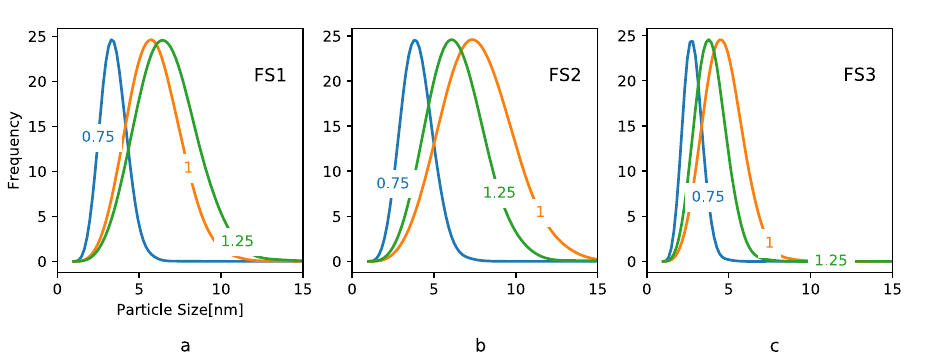
Figure 11. Particle size distributions at the exit of the reactor with selected flow ratios for all the flow sets: ( a ) FS1, ( b ) FS2, and ( c )